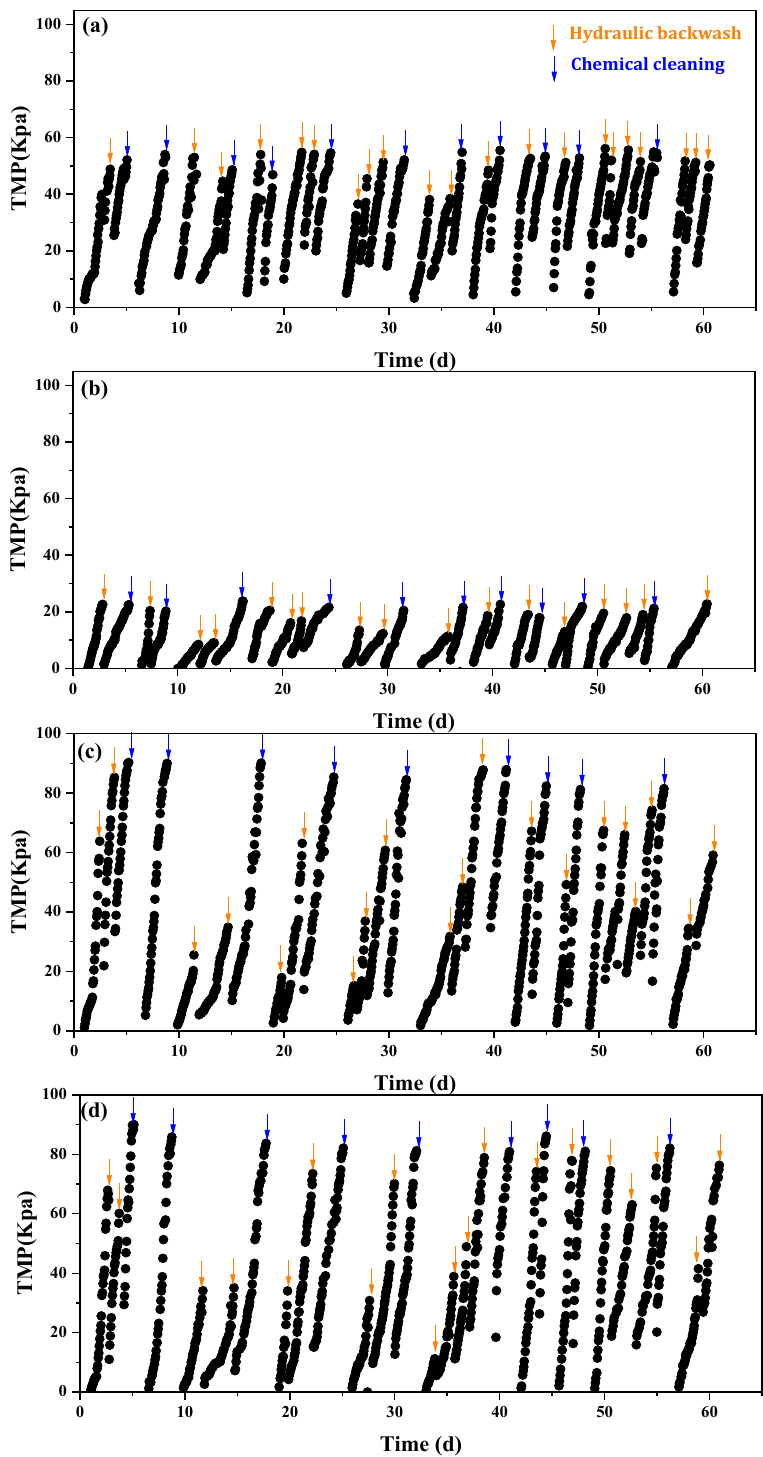
Figure 6. TMP changes of different membranes in the CMBR ( a – d ): C5, C7, C13, C20. Figure 7a shows the distribution of cake layer resistance (R c ) and pore-blocking re- sistance (R p ) for different membranes. It could be seen that for C5, the contribution of the cake layer and pore blockage to membrane fouling were essentially the same, while with the increase of membrane pore size, the proportion of cake layer resistance in total fouling resistance was significantly increased. The result manifested cake layer fouling played a dominant role in the membrane fouling of ceramic membranes with relatively larger pore